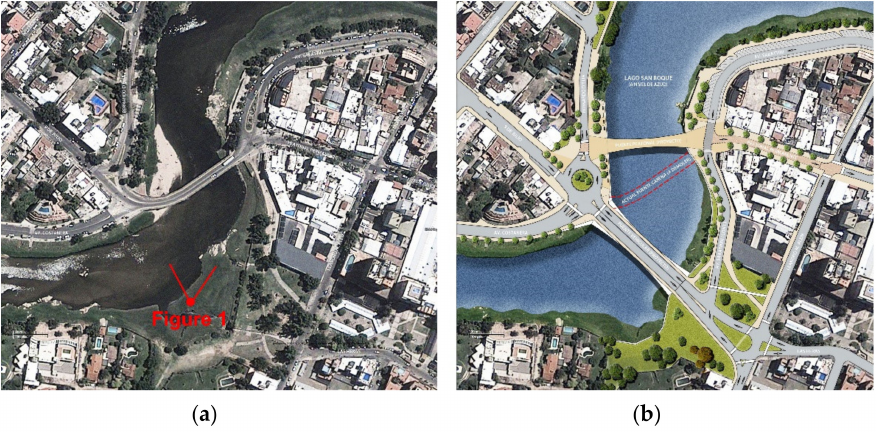
Figure 7. ( a ) The downtown area connected by the existing bridge of 1889. ( b ) The urban vision shows substantial public space reconfiguration, a proposed mixed bridge (bottom), and the imple- mented pedestrian bridge (top). (Credit: Provided by the planning department of Villa Carlos Paz (public